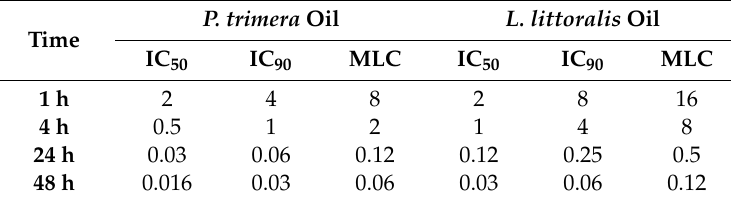
Table 3. In vitro anti- T. vaginalis activity of essential oils from the leaves of P. trimera and L. littoralis.